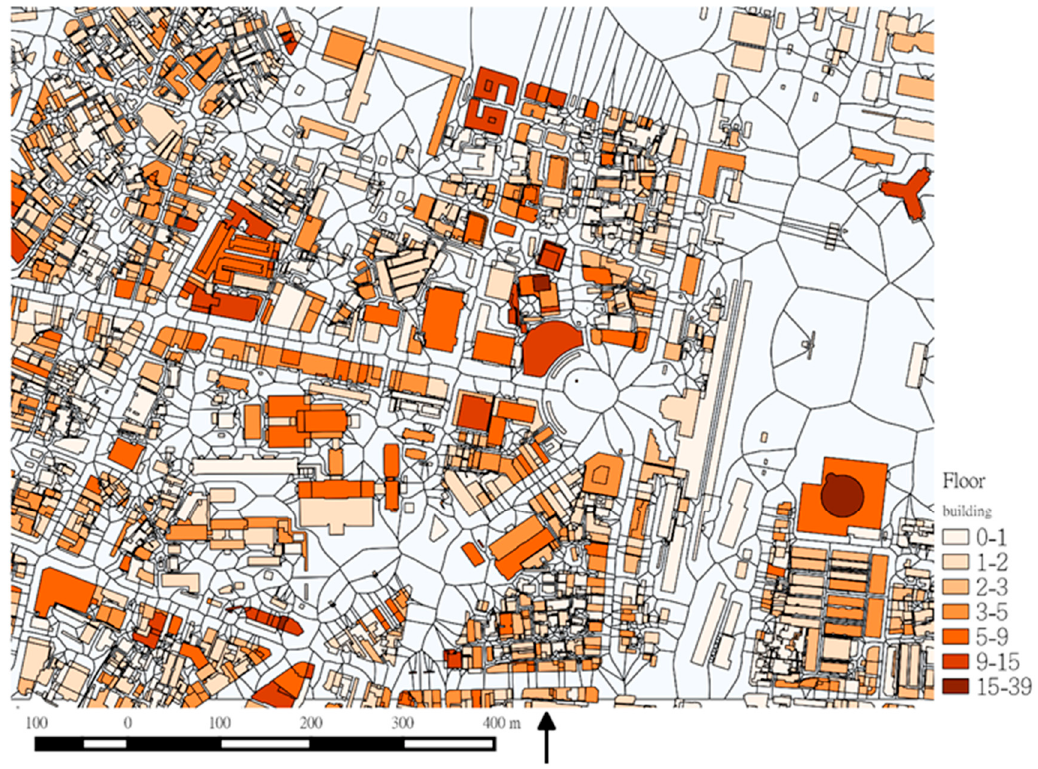
Figure 3. The digital building model for the area of interest including the Tainan train station.